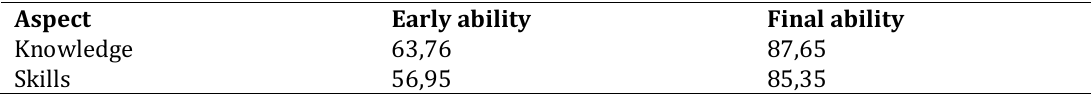
Table 3 Summary of training results